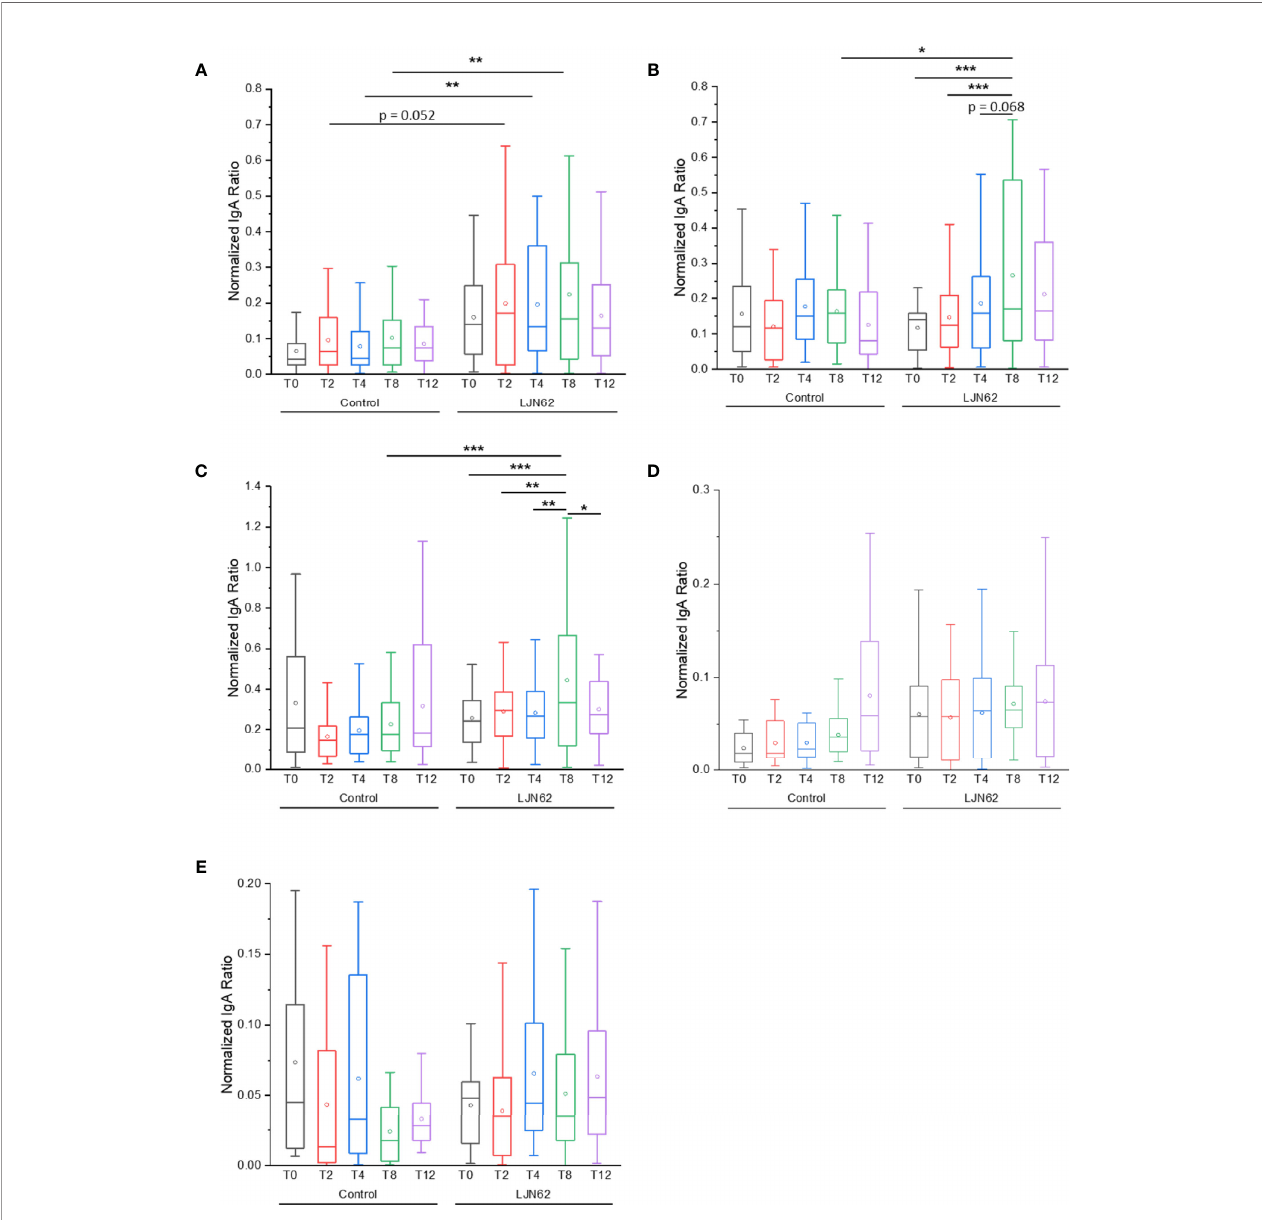
FIGURE 8 | IgA ACAb generation against L. johnsonii N6.2 proteins and NV. Normalized IgA ratio of speci fi c IgA generated against the antigens, NV (A) , Sdp_SH3b2 (B) , Sdp_SH3b6 (C) , Eno3 (D) and LexA (E) , over total plasma IgA. *p < 0.05, **p < 0.01, and ***p <